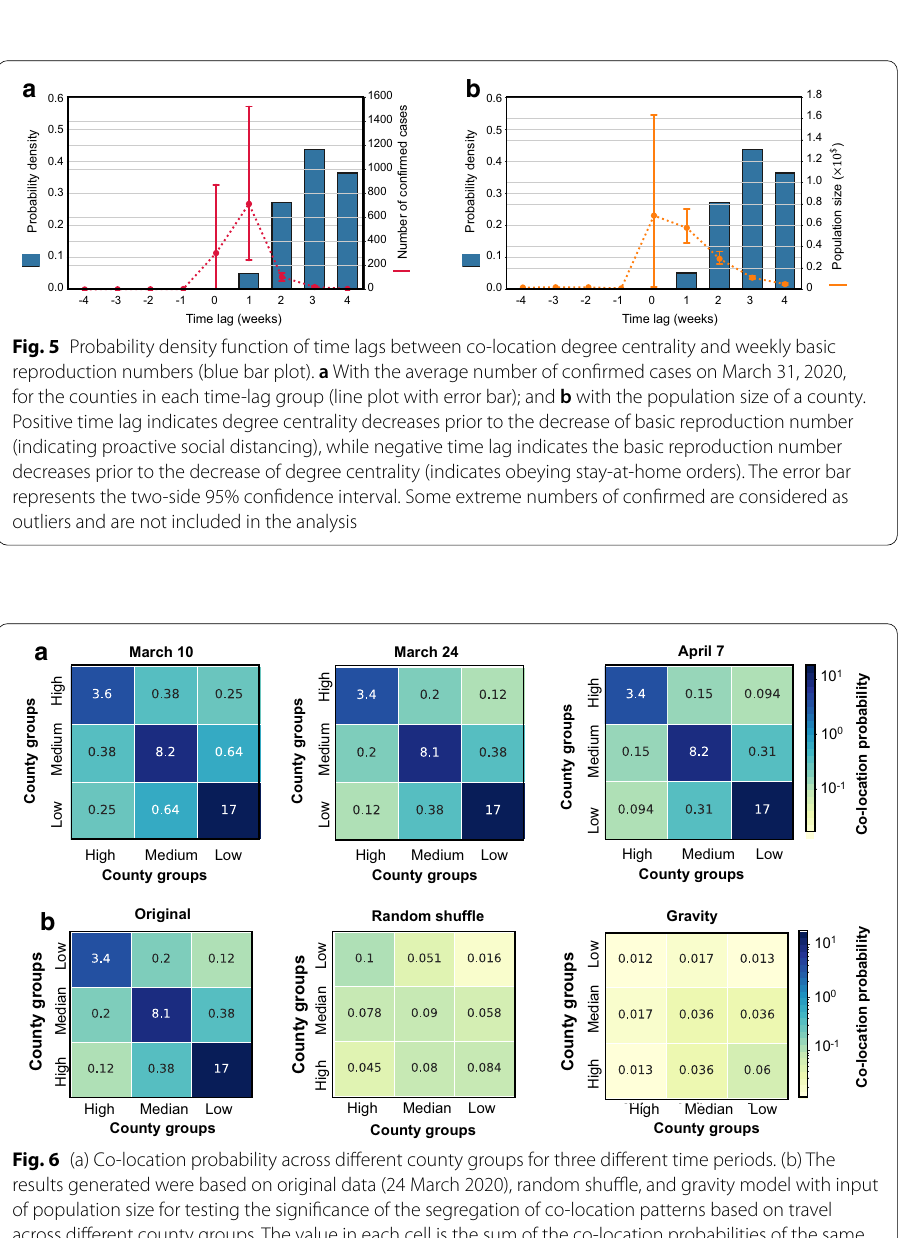
the greatest population size tend to have a synchronic relationship between co-loca- tion degree centrality and the basic reproduction number, or the co-location degree centrality might decrease one week prior to the basic reproduction number. Hence, the population size of a county could be related to the time lags and become an indi- cator of the effect of travel reduction on diminishing the basic reproduction number. The results confirm that travel reduction in counties with a high number of cases and